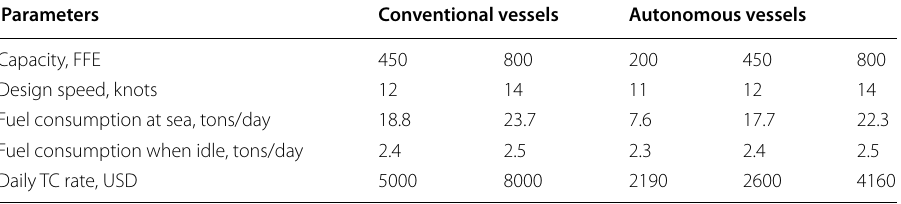
Table 2 Parameters for conventional and autonomous vessels according to their size Parameters Conventional vessels Autonomous vessels Capacity, FFE 450 Design speed,